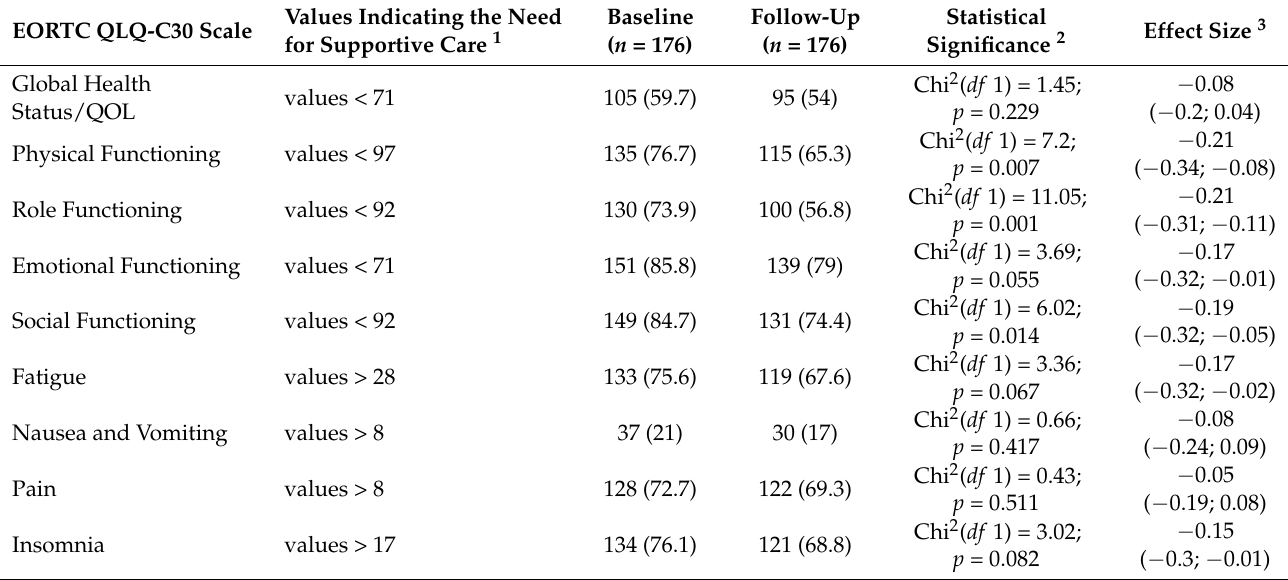
Table 4. Absolute and relative frequencies of 176 young adult non-metastatic breast cancer pa- tients with minor children participating in a 3-week inpatient mother–child rehab program with EORTC QLQ-C30 scores indicating a need for supportive care at baseline and follow-up according to thresholds proposed by Lidington et al.